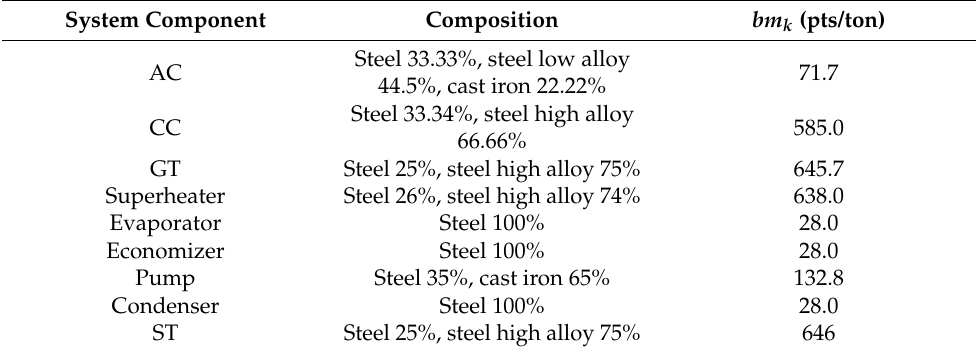
Table 6. Environmental impacts of the equipment weight